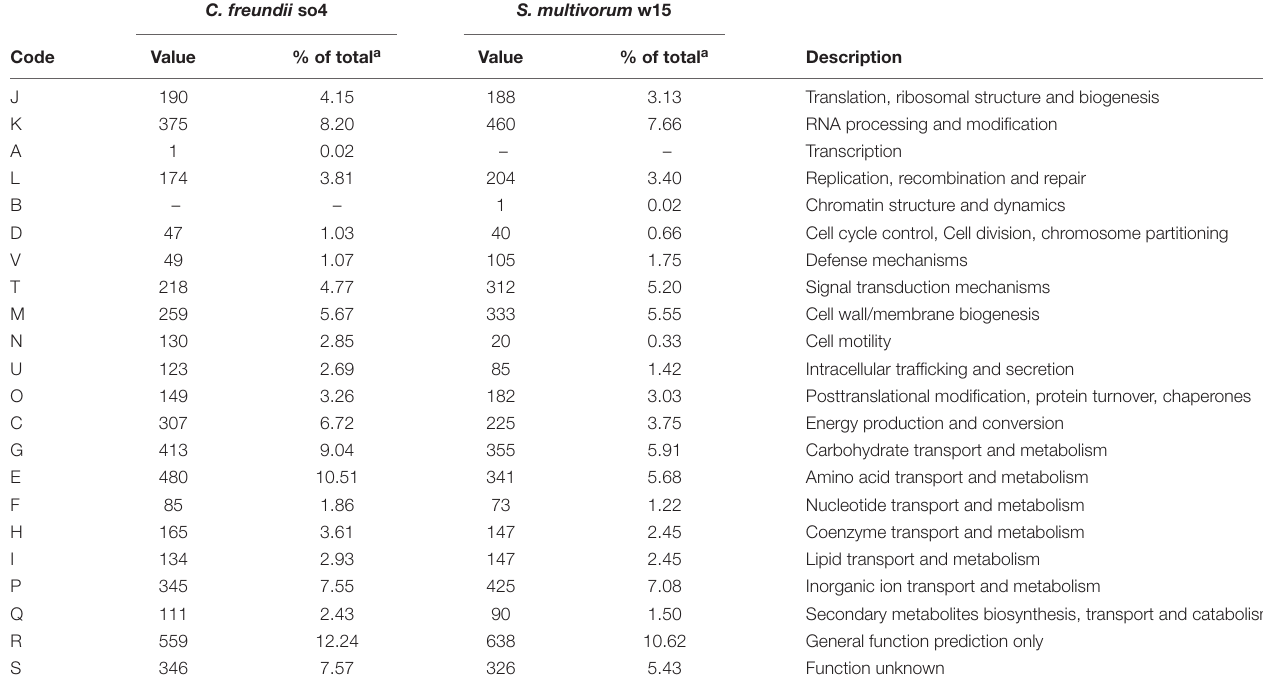
TABLE 2 | Number of genes associated with general COG functional